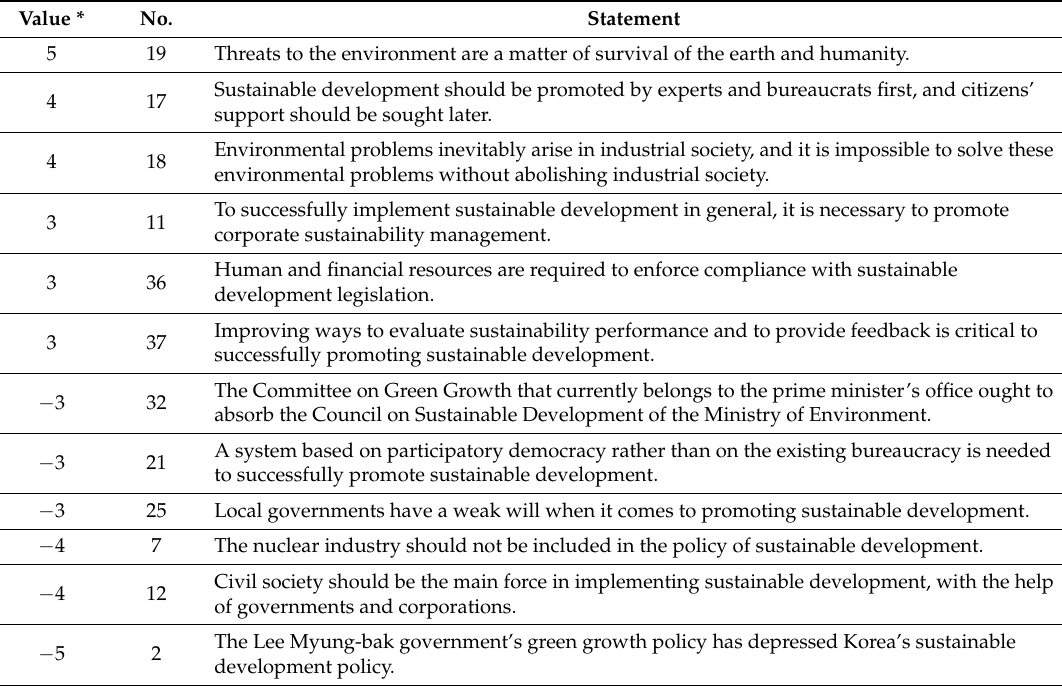
Table 10. Elitists’ Q